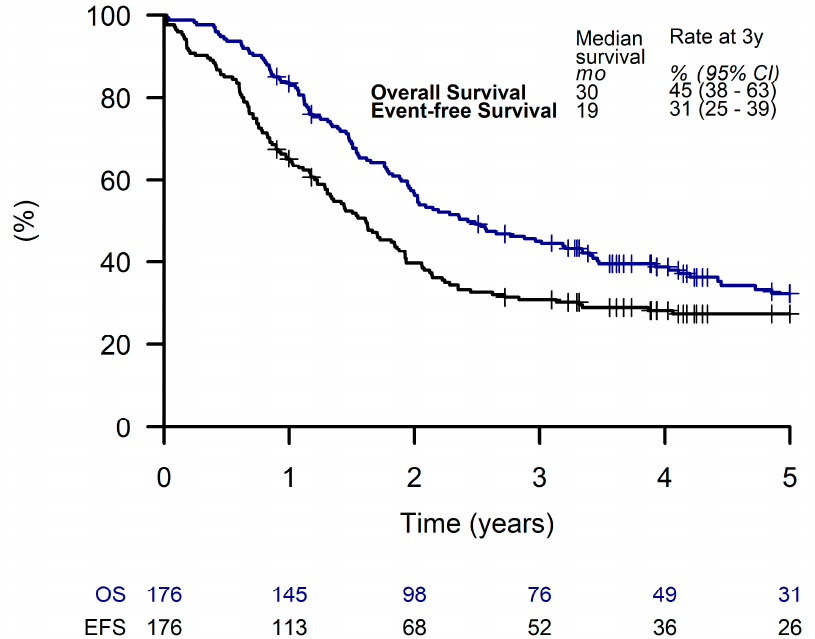
Figure 2. Overall survival and event-free survival of all patients.